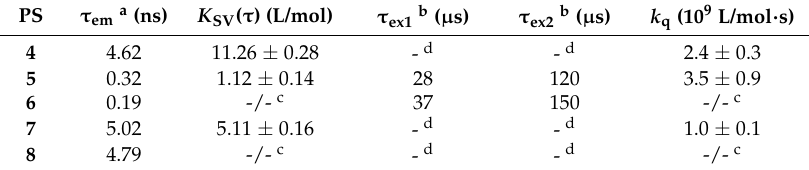
a ± 10%; b ± 20%, deoxygenated solution; c The specified experiments were not performed for these dyes; d no long-living species